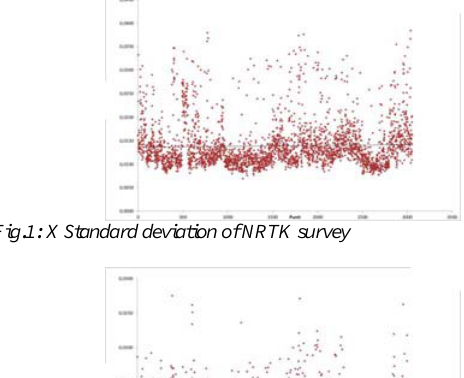
Fig.1: X Standard deviation of NRTK survey